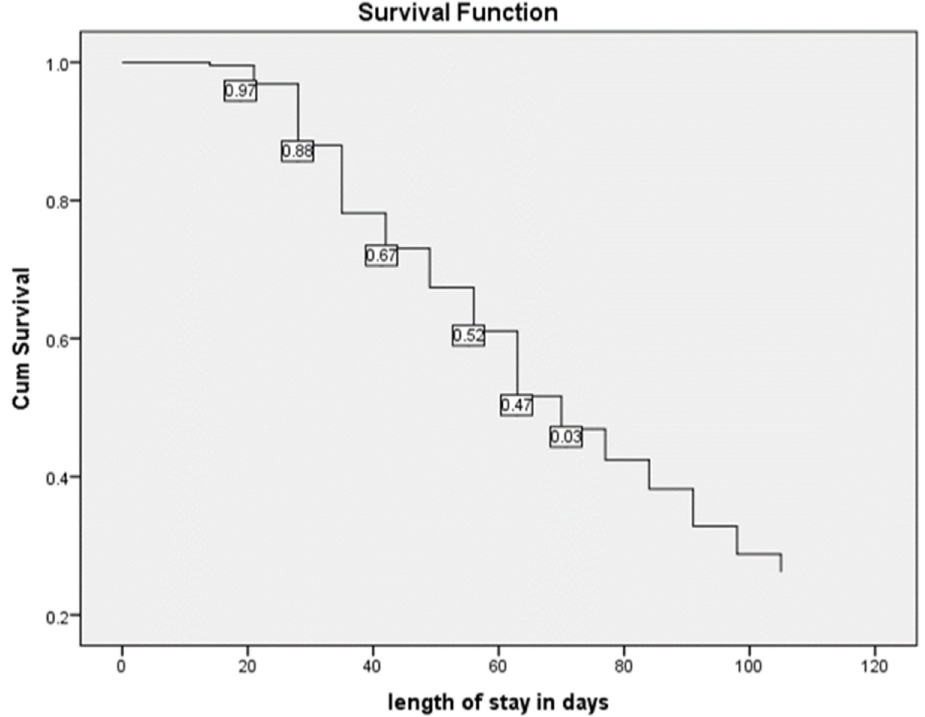
Fig 2. Overall Kaplan Meier recovery estimate of children treated under OTP in Dire Dawa, Ethiopia; January 2013 to December 2016.